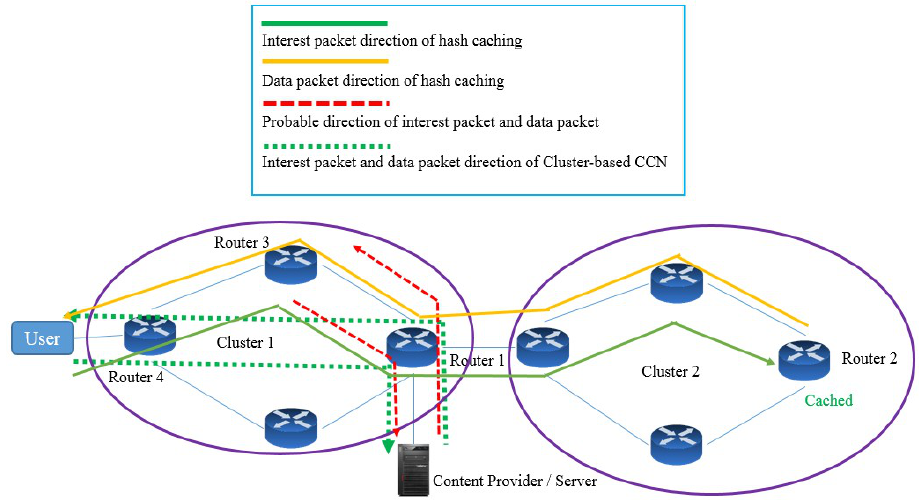
Figure 8. Enhanced hash caching.